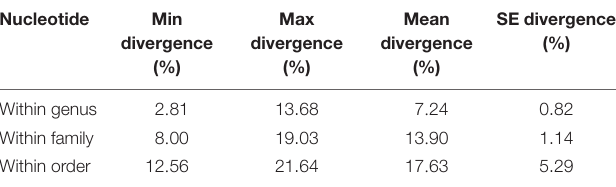
TABLE 3 | Genetic divergence (K2P percentage) at each taxonomic level.